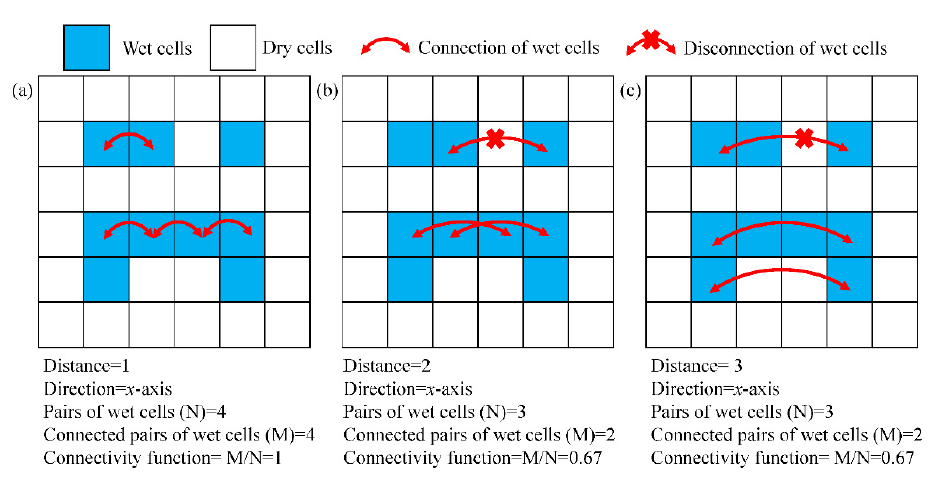
Figure 3. Example of the calculation of the connectivity function using 8-way connectivity (allows cells to connect by edge and corner vertex) in the x -axis direction. ( a – c ) represent the pairs of wet cells and connectivity function values at different distance scales. When the distance is 4 or 5, the value of the connectivity function is 0 because there are no pairs in the x -axis direction at that distance.